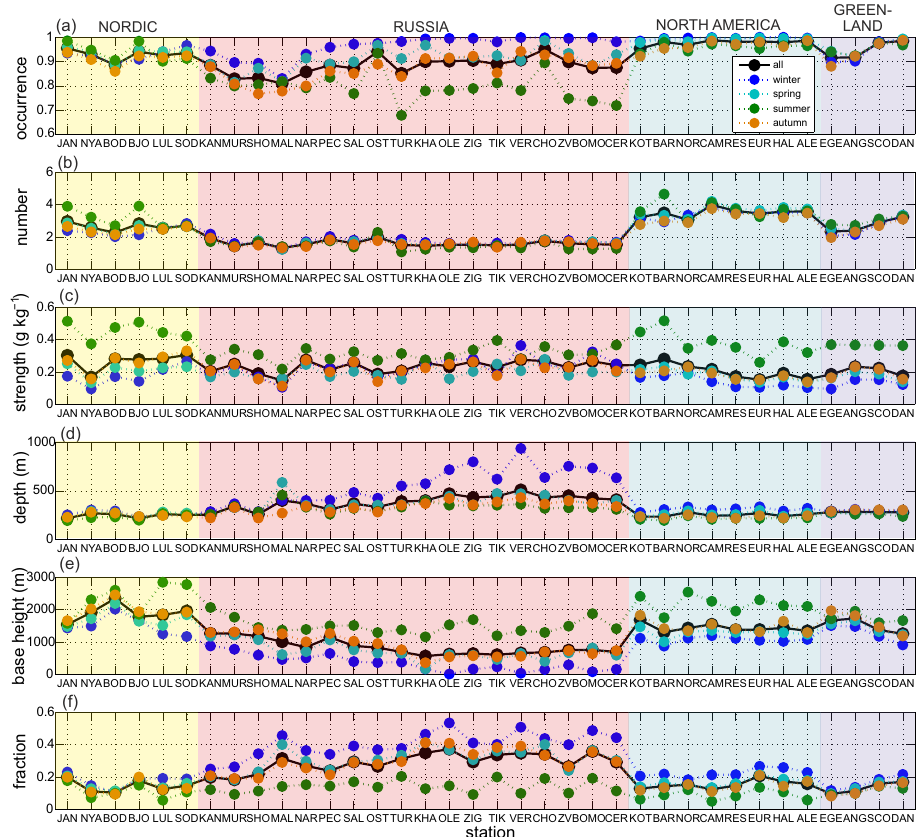
Fig. 3. (a) Occurrence of humidity inversions, (b) mean number of humidity inversions in a single profile, (c) median strength, (d) median depth and (e) median base height of humidity inversions, and (f) the fraction of surface-based humidity inversions.